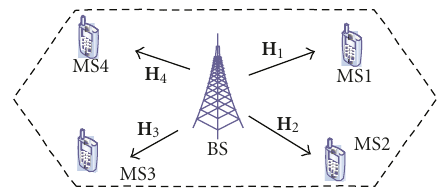
Figure 1: The configuration of MU-MIMO